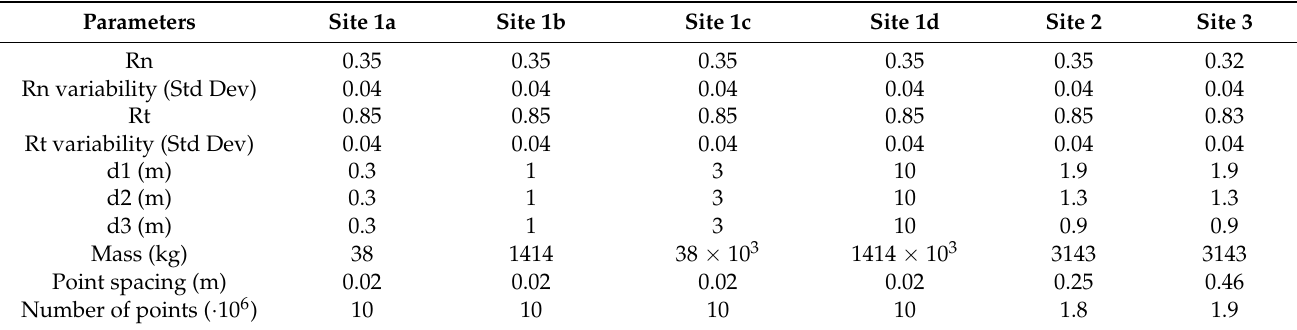
Table 2. Characteristics of the sites for the rockfall